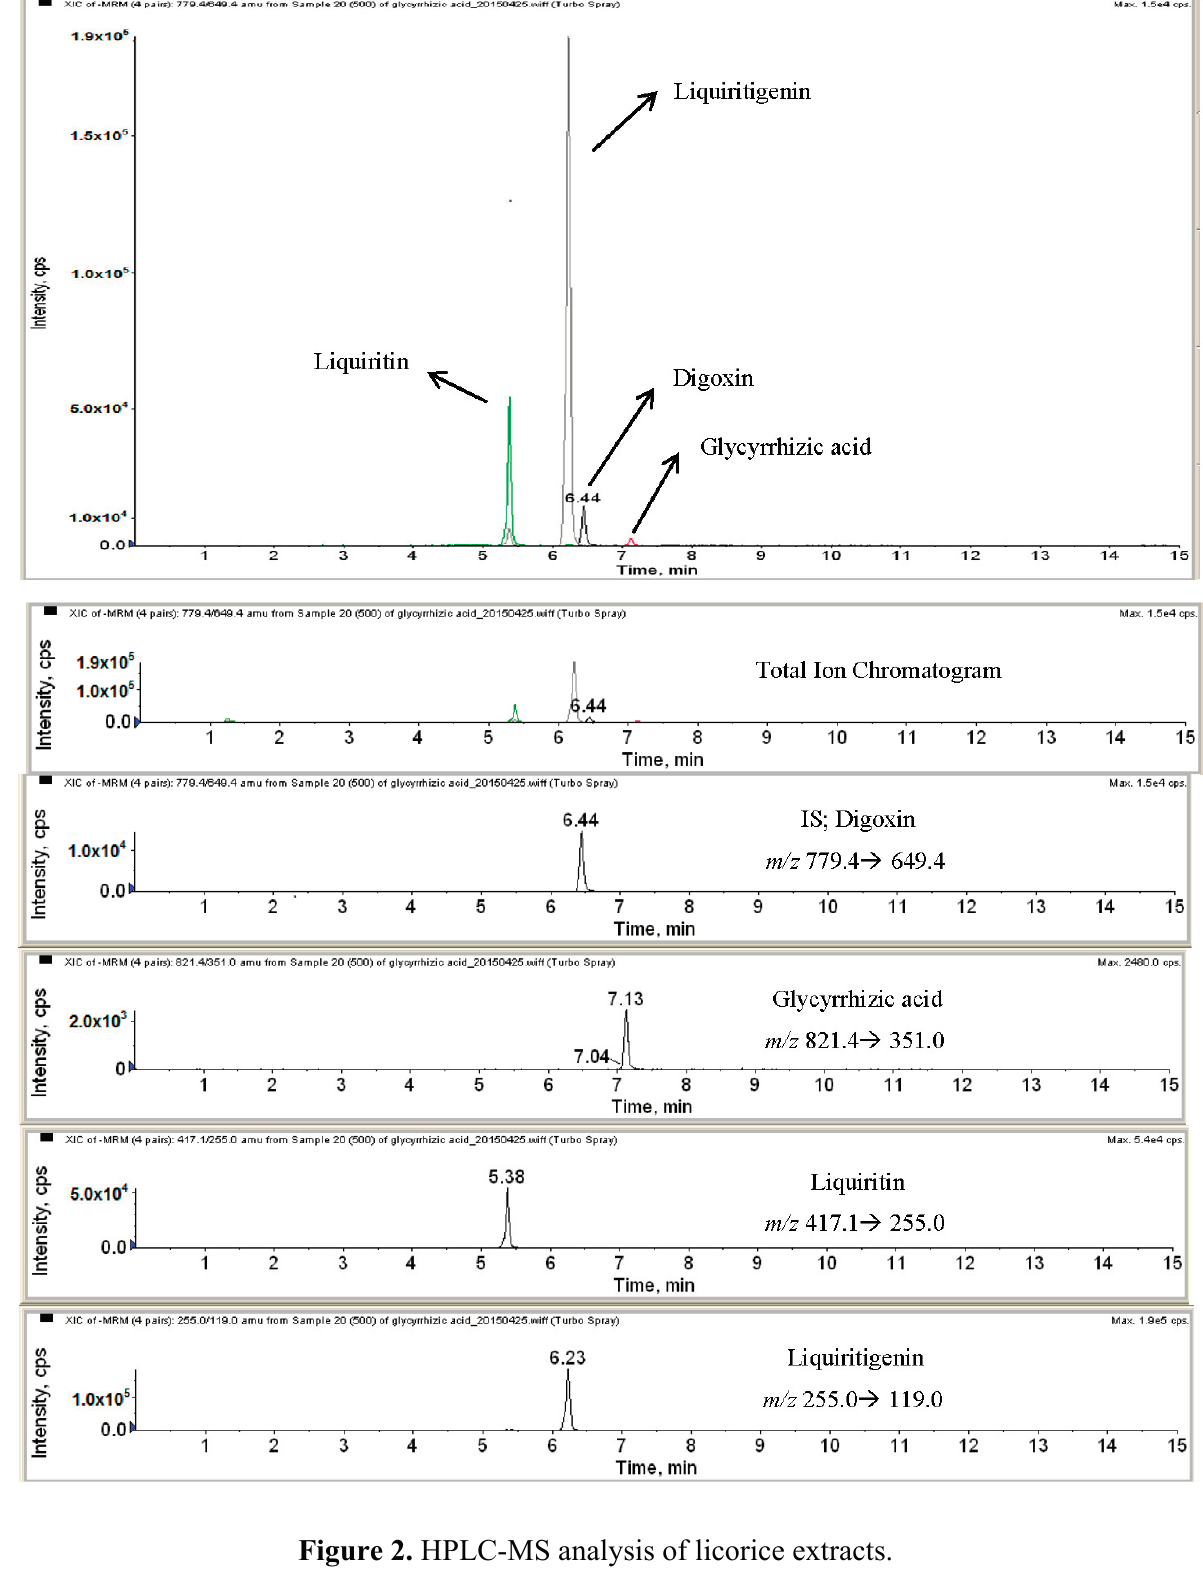
Figure 2. HPLC-MS analysis of licorice